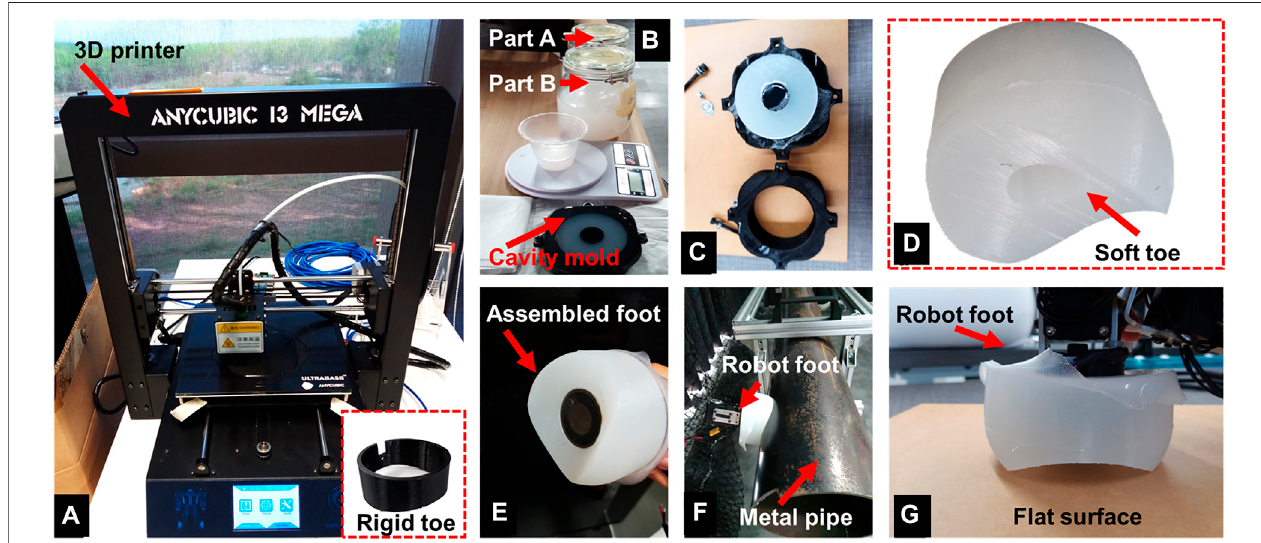
FIGURE6| Anoverviewofthefoot-toefabricationprocess. (A) A3DprinterwasusedtofabricatethePLAbasedrigidtoe(showninthebottominset),andacavitymold for the silicone-based soft toe. (B) The silicone elastomer (parts A and B) was mixed in a weight ratio of 1:1 (by weight) and poured into the cavity mold. After mounting the negativepartontop,the moldwas leftfor about 4 hours at room temperature tocure. (C) Postcuring, the negative part was unmounted resulting inthe softtoe D). (E) The softtoewasattachedtotherigidframewiththeelectromagnetsuchthatthemagnetcouldfullyfaceitunderneath. (F) Thehybridrigid-softfootonthemetalpipewiththe soft toe adapting to the pipe diameter. (G) The hybrid rigid-soft foot on a fl at surface with its edges undergoing minor deformation while the magnet remains fully attached.